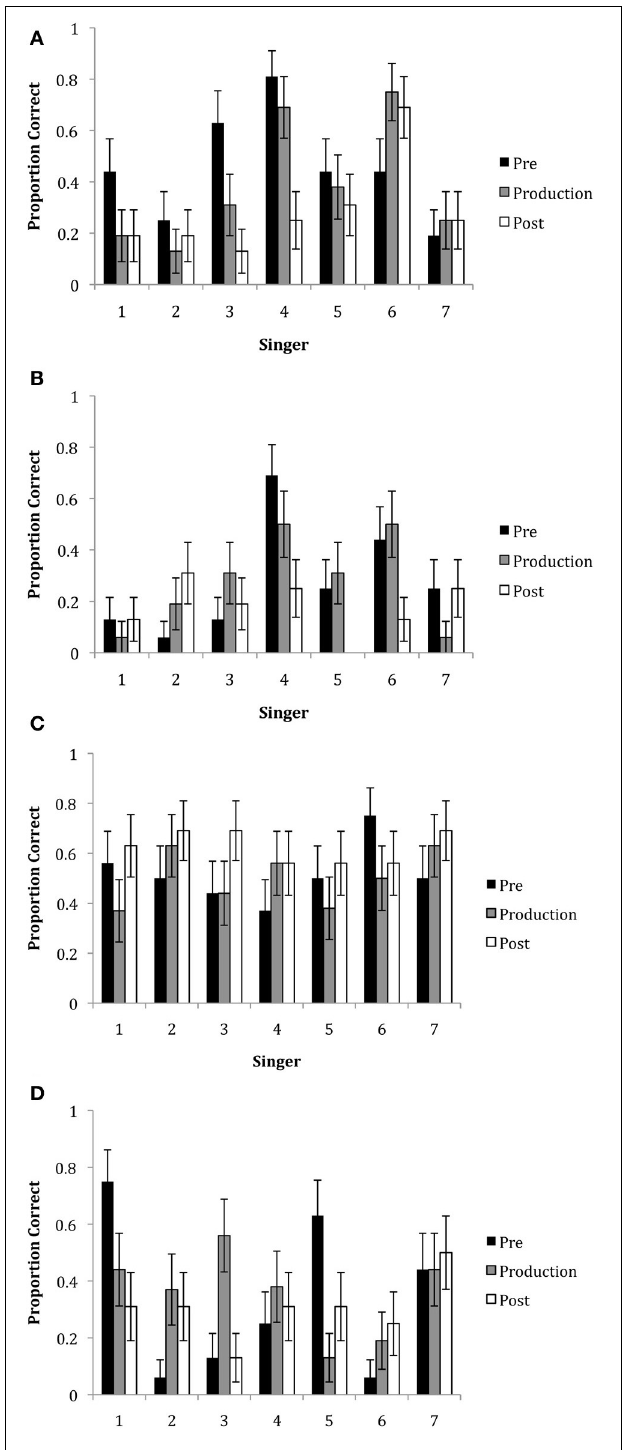
FIGURE 5 | The proportion of correct responses for the emotions of (A) happiness, (B) irritation, (C) neutral and (D) sadness for each of the seven singers in each of the three epochs. Note that missing bars indicate that no participant accurately decoded the emotional